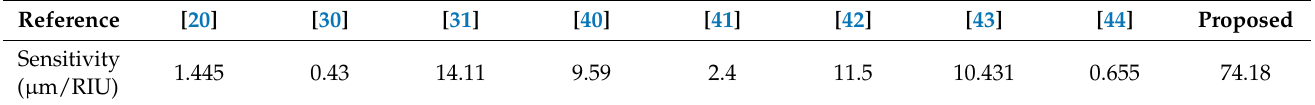
Table 1. Sensitivity comparison of different metamaterial devices.